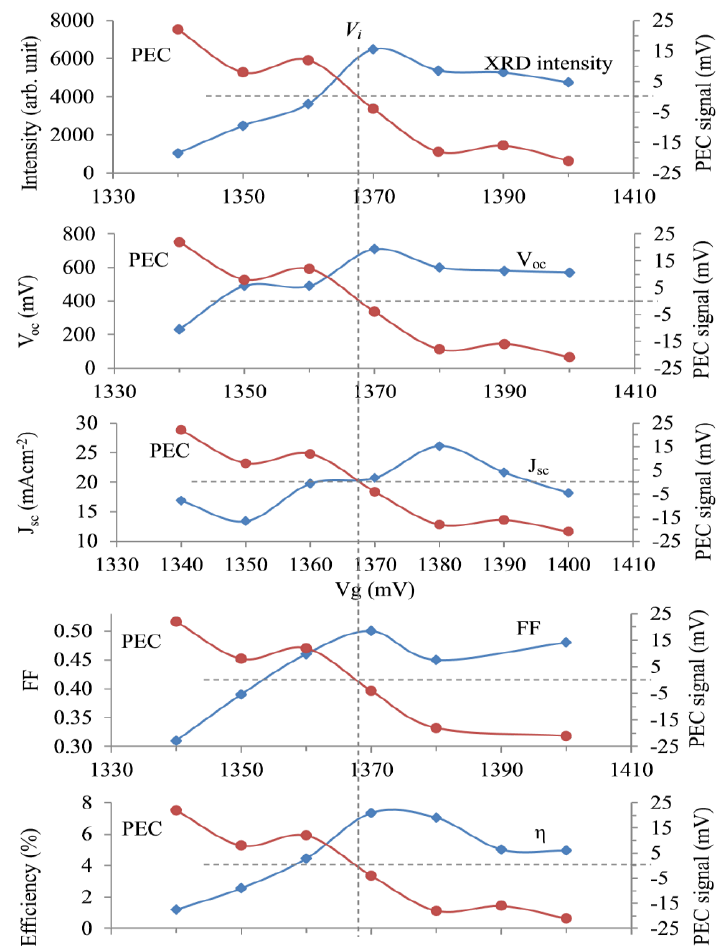
Figure 8. Typical variation in the PEC signal for CdCl 2 -treated CdTe is shown in RED in each panel to separate the p-type and n-type regions. The intensity of the dominant (111) XRD peak is shown in the first panel, indicating the best crystallinity at around V i = 1368 mV on the Cd-rich side. The device parameters for glass/FTO/CdS/CdTe/Au solar cells fabricated with CdTe layers grown in the vicinity of the transition voltage, V i , are shown in the other four panels. Note that all device parameters are higher when the CdTe layers are rich in Cd and n-type in electrical conduction [34]. As discussed in Section 2.1, a CdTe electrolyte was prepared, and CdTe layers were grown on glass/FTO substrates at different voltages. PEC measurements were carried out to determine the V i, the conversion voltage from p-CdTe to n-CdTe. For this particular bath, the V i was 1368 mV. The PEC curve obtained for the CdCl 2 -treated layers is presented in all five panels in Figure 8 in red colour. The intensity of the dominant (111) XRD peak shown in the first panel indicates that the highest crystallinity was obtained closer to the V i on the Cd-rich side. The devices made in an identical way with the Au contacts were measured, and device parameters were plotted separately against V g in the other four panels.